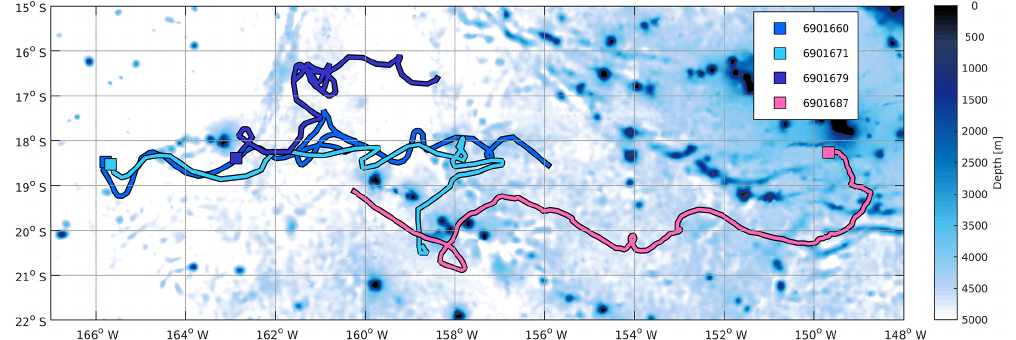
Figure 2. Trajectories of the studied floats superimposed on bottom topography (in m). The squares represent the initial location of the floats.